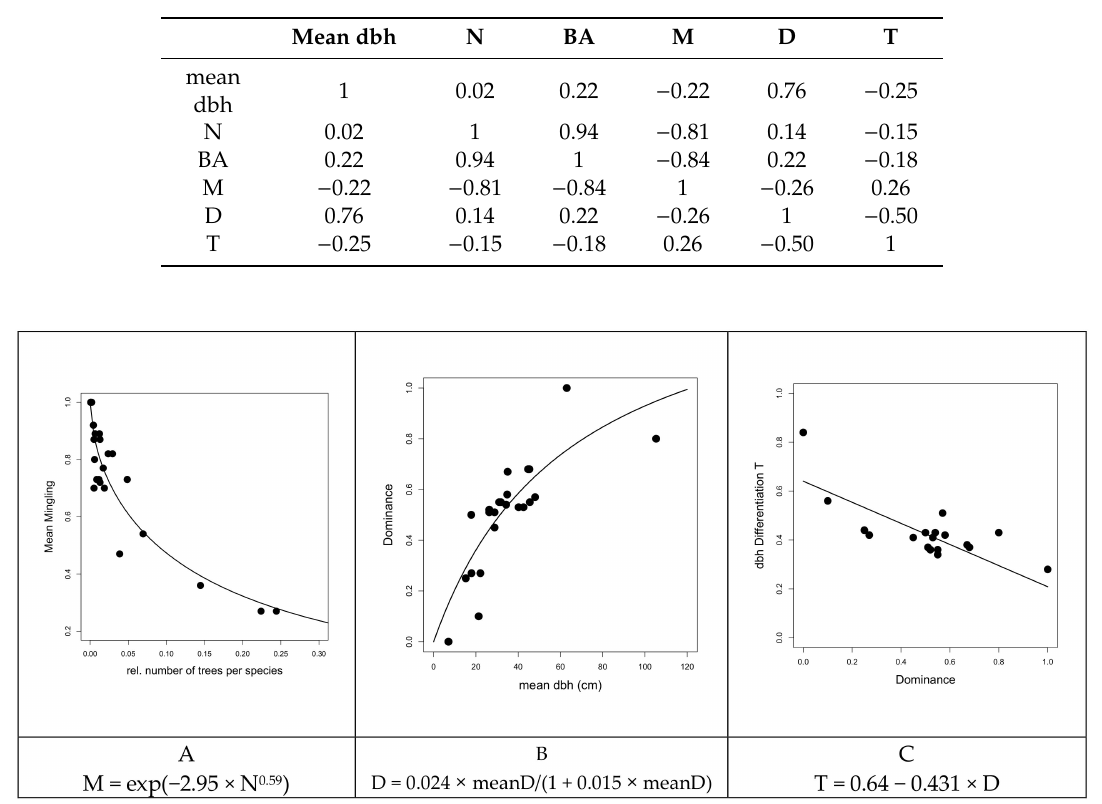
Figure 4. The relationships between species-specific variables in the three plots. Shown are the number of trees per ha and the mean neighborhood mingling (M) with the estimated non-linear model below ( A ); the mean dbh (cm) and the mean neighborhood dominance (D) with the estimated Monod model below ( B ); the mean neighborhood dominance and the mean neighborhood Di ff erentiation (T) with the estimated model below ( C ).